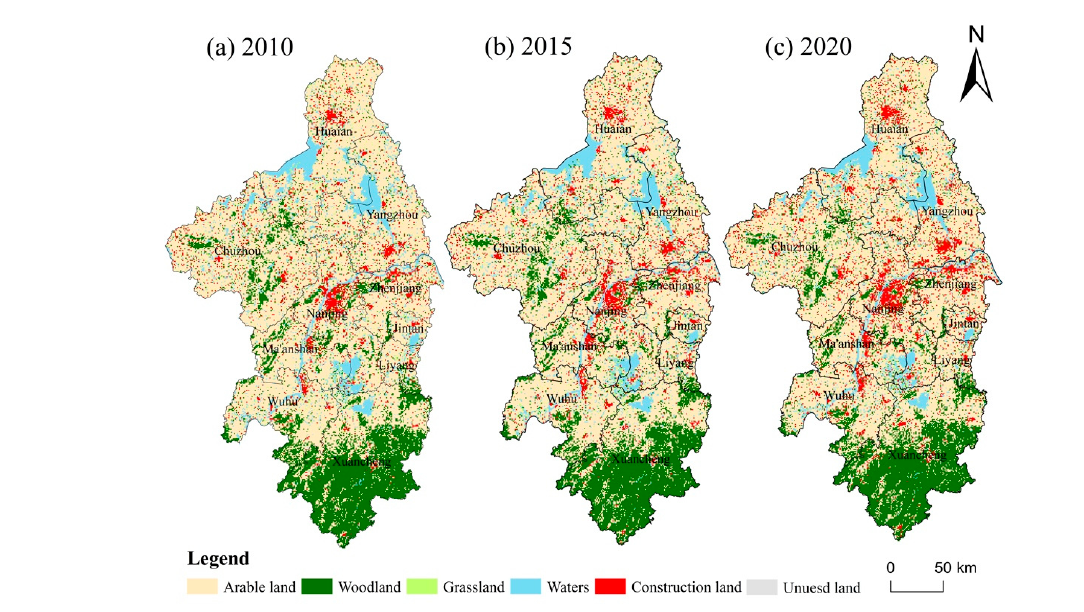
Figure 3. Land use map of Nanjing metropolitan area. ( a ) 2010 land use map; ( b ) 2015 land use map; ( c ) 2020 land use map. Table 1. Data sources.